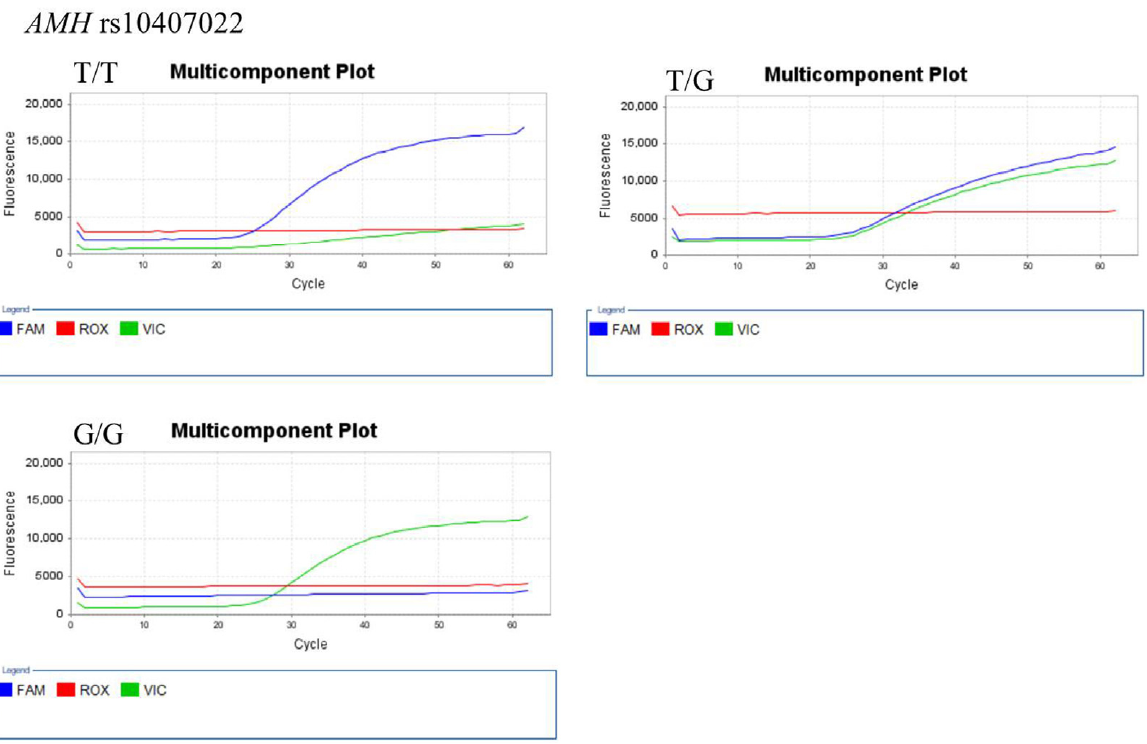
Figure 1. Representative TaqMan assay for AMH rs10407022 genotyping. The FAM (blue) and VIC (green) fluorescence probes detect T and G alleles, respectively. The ROX (red) fluorescence probes are used for calibration.